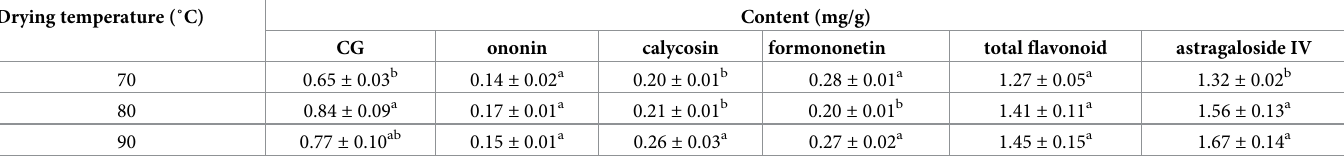
Note: 1. Values in the table are means ± standard deviation; 2. a,b: values with the same superscripts are not significantly different ( P > 0.05), and those with different superscripts are significantly different ( P <